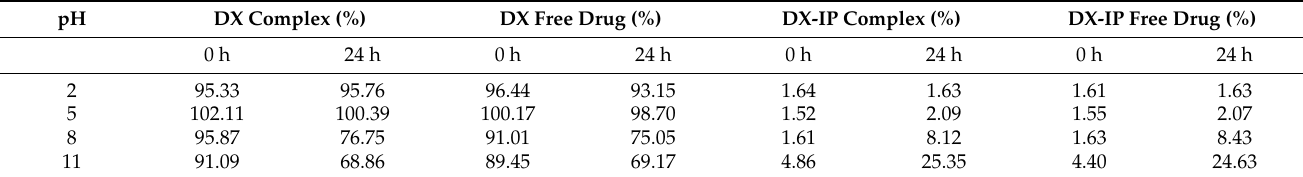
Table 1. Doxycycline (DX) and impurity (DX-IP) content in solutions of pure (free drug) and com- plexed drug (Complex) at different pH